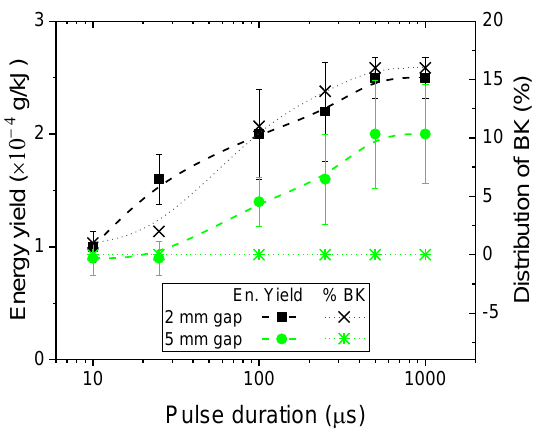
Figure 9. Energy yield and breakdown distribution according to the pulse duration for pin-to-pin discharges in Cr(VI) solution (47 mg/L, σ = 4 mS/cm, pH = 2.3), U = 9kV, V = 100 mL, electrode length = 0±10 µm, f = 50 Hz.